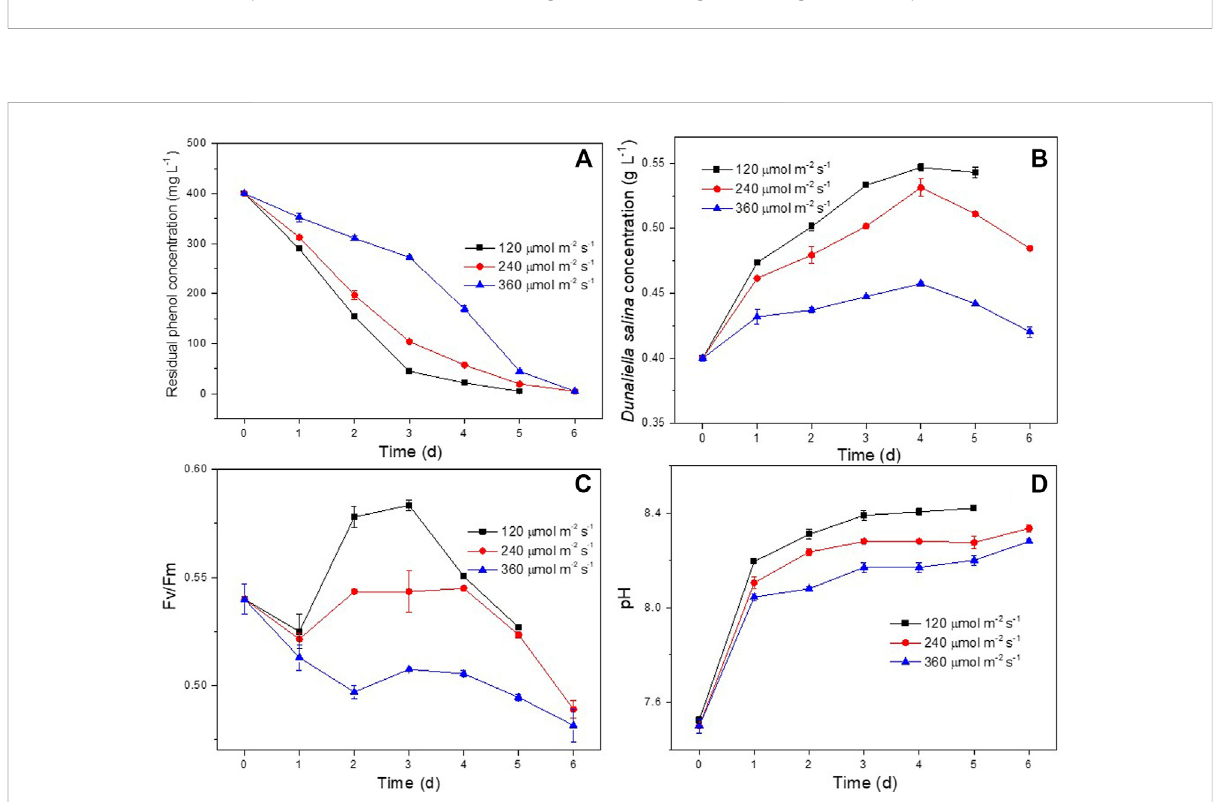
FIGURE 4 Effectoflightintensityonphenoldegradationandthegrowth of D.salina :phenolremovalef fi ciency (A) ,biomassconcentrations (B) andFv/Fm values (C) of D. salina and pH of culture medium under 0.4 g L − 1 D. salina , 0.2 g L − 1 H. mongoliensis , pH 7.5 and 25 ° C